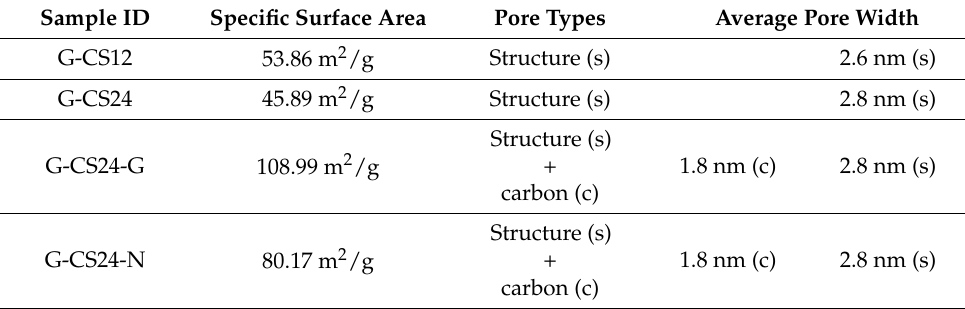
Table 2. The porosity analysis for the PCL/CS porous monoliths.